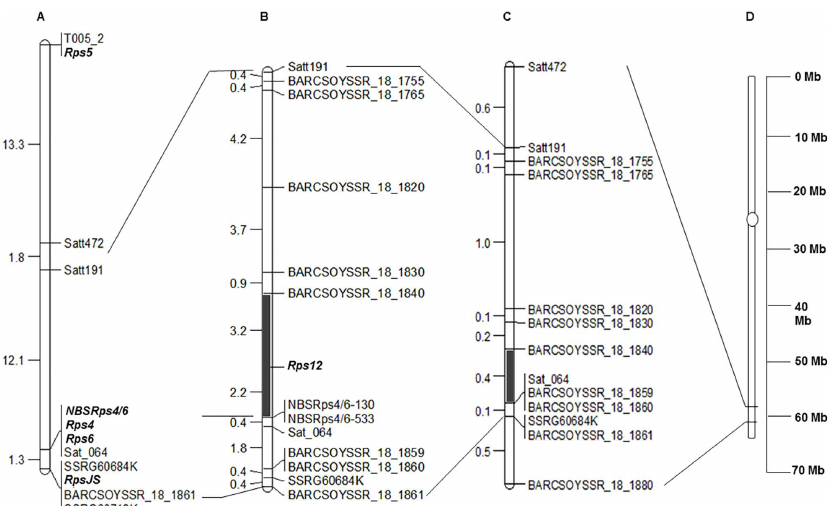
Fig 4. Genetic and physical map of the Rps12 region. (A) Molecular geneticmapof the Rps lociof the lower arm of Chromosome 18 (S1DFig). ( B)Geneticmap of the Rps12 region.SSR markersare shownon the right sideof the map andcorrespondinggeneticdistancesbetween two adjacent loci are shownon the left side of the map in centi-Morgan(cM). The Rps12 regionis shownwith a solidline.(C) Physicalmap of SSR markerson Chromosome 18 accordingto the soybeanreferencegenomesequence( Glycinemax v1.1: http://soybase.org). The correspondingphysicaldistances betweentwo adjacentloci are shownon the left sideof the map in mega basepairs(Mb). The Rps12 physicalregiondefinedby two molecular markers(BARCSOYSSR_18_1820 and Sat_064)is shownby a soliddark line.(D) Physicallocationof the Rps12 regiononChromosome18 ( Glycine max v1.1: http://soybase.org).The two longbars indicatetwo arms of Chromosome 18, the circleindicatesthe approximate positionof the centromeric region,andthe markedportionindicatesthe regioncontaining Rps12